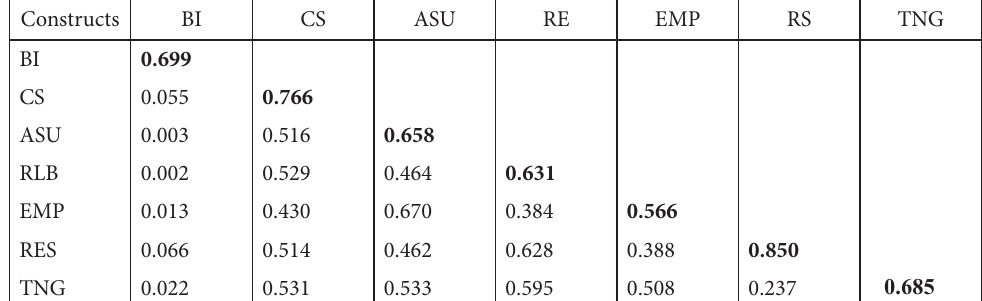
Table 3. Fornell-Larcker criteria (adopted from Al-Gahtani et al.